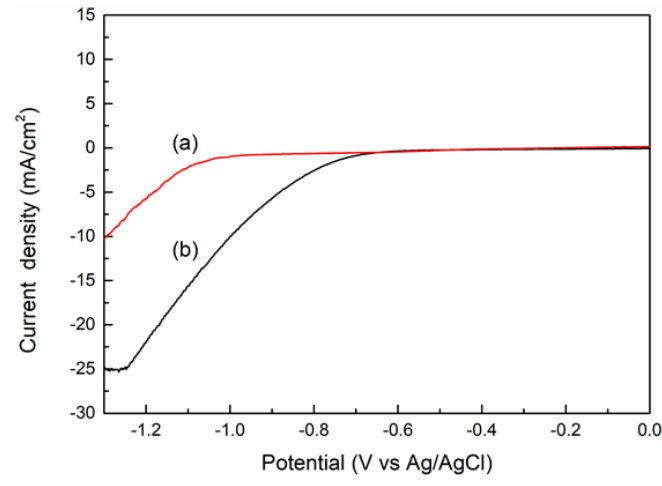
Figure 8. Linear sweeping voltammetry (LSV) curves of electrodes at various reaction times in a 0.1M NaHCO 3 solution at a scan rate of 20 mV/s: ( a ) PL-12h; ( b ) HL-12h.